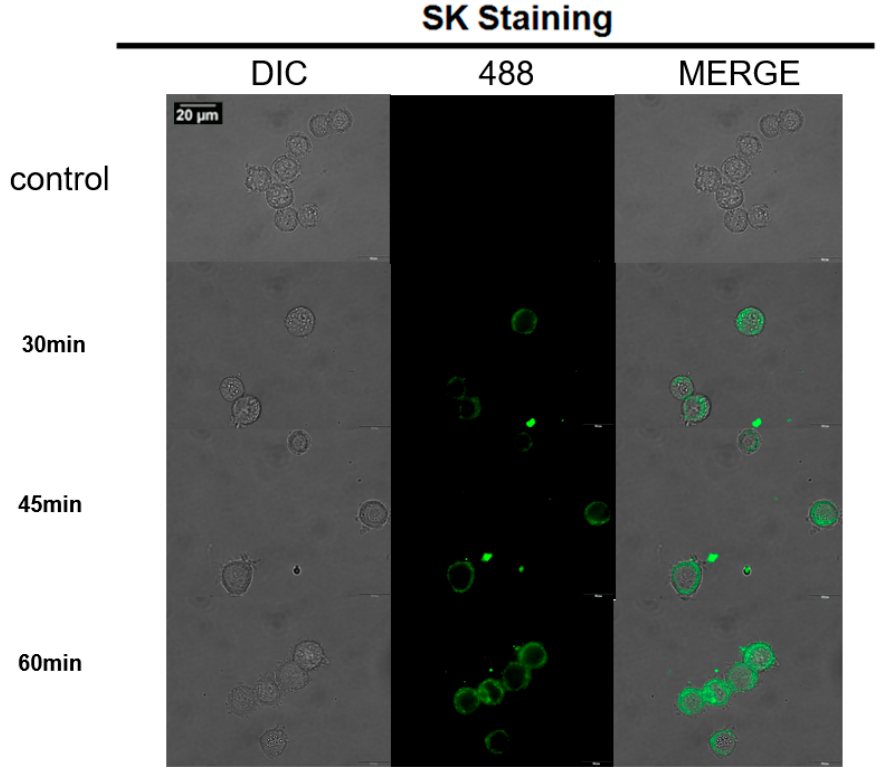
Figure 2. Fluorescence imaging of BSA-biotin-fitc labeled HER-2 in SK cells by avidin and primary antibody-biotin at different time points. 3.3. The Specific Targeting of BSA-Biotin-Au 25 Clusters and Primary Antibodies Containing